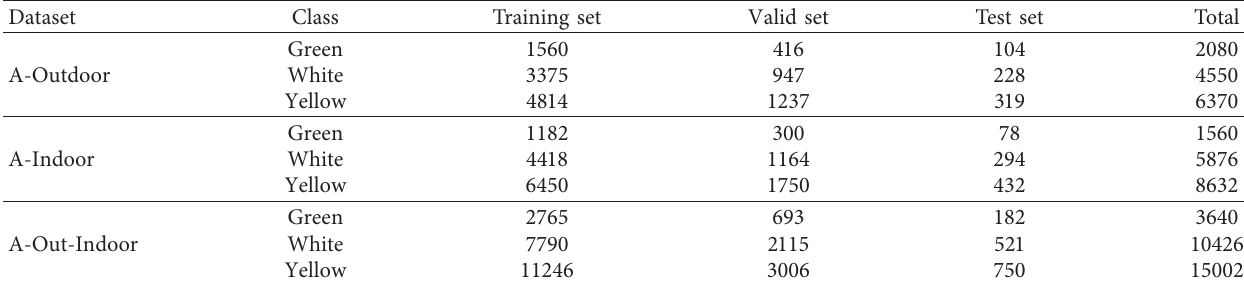
Figure 4: Sample of image augmentation in outdoor and indoor datasets. (a) Original. (b) Spatter. (c) Noise. (d) Blur. (e) Motion. (f) Contrast. (g) Brightness. (h) Saturate. (i) Flip. (j) Affine. (k) Shear. (l) Rain. (m) Clouds. (n) Rain drops. Table 4: Dataset details for data augmentations.